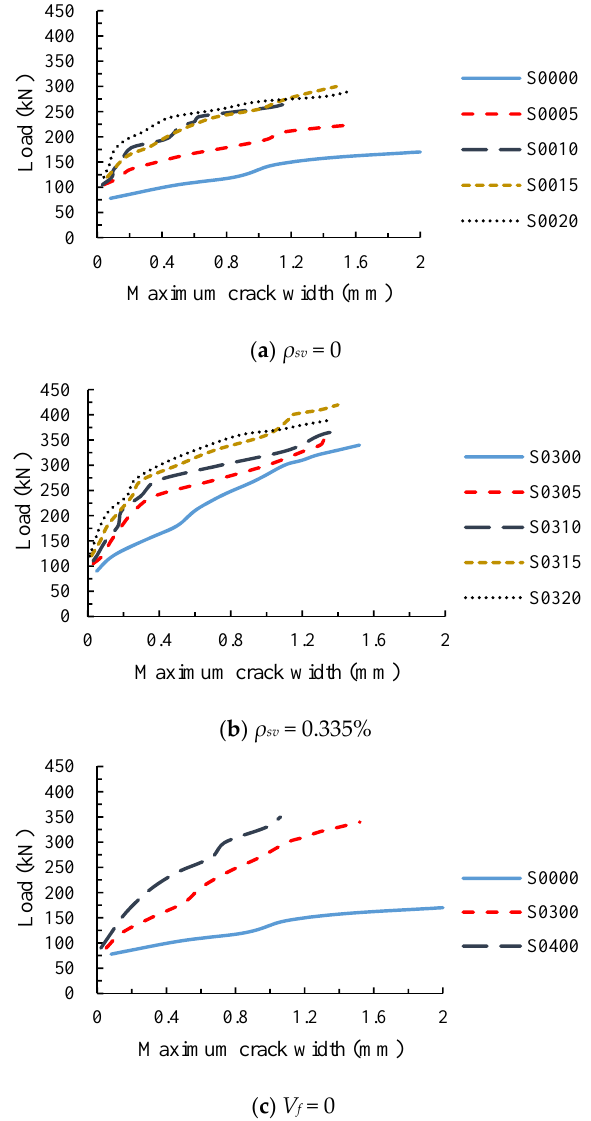
Figure 8. Load-maximum crack width of specimens. ( a ) The test beams without stirrups; ( b ) The test beams with stirrup ratio 0.335%; ( c ) The test beams without steel fiber.